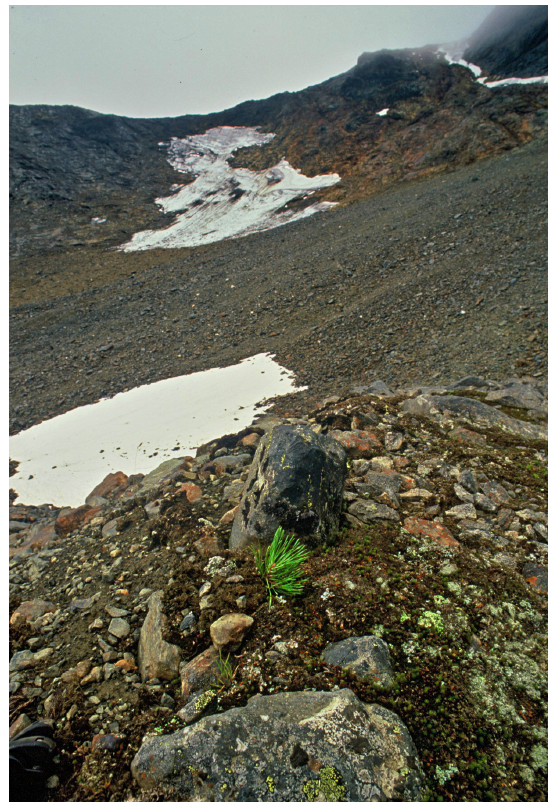
Figure 29: A few years old pine sapling which has germi- nated in an exposed glacier forefield, about 700 m higher than the local treeline. Mt. Storsola, 1370 m a.s.l. 5 Sep- tember